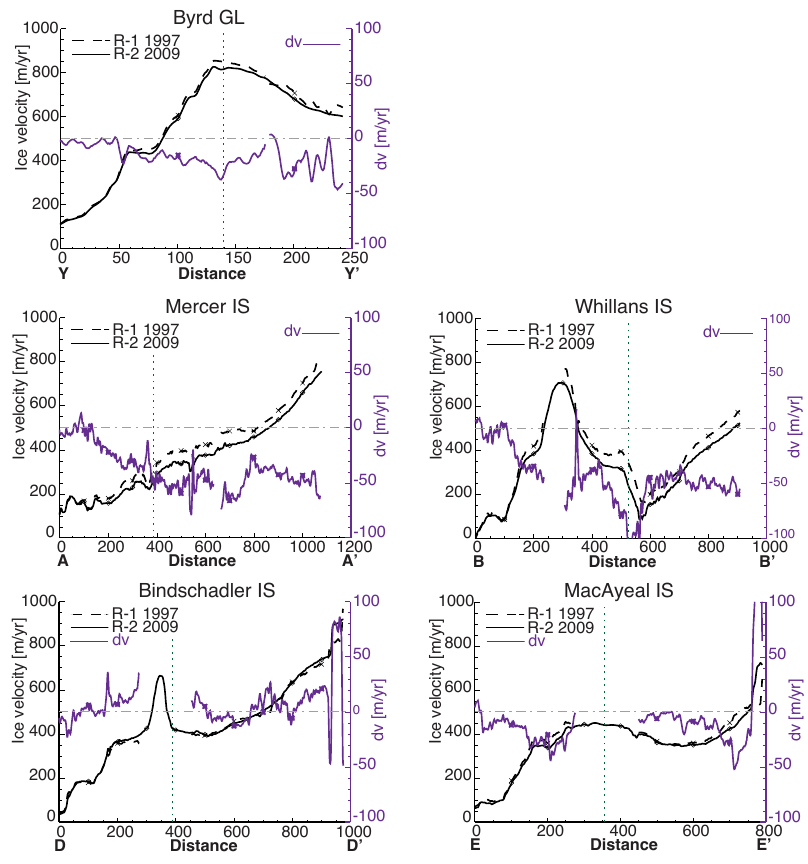
Fig. 3. Flow line plots for the Ross Ice Shelf tributaries showing the absolute velocities for 1997 and 2009 and the 12-yr difference in speed d v . Markers set every 100km correspond to the markers shown in Fig. 2. The vertical dashed line is the 2009 grounding line.